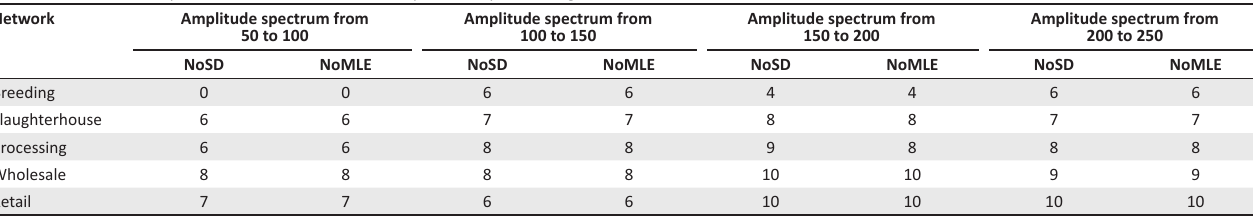
TABLE 8: Results of the post hoc test, data sets sorted by variable period length. Network